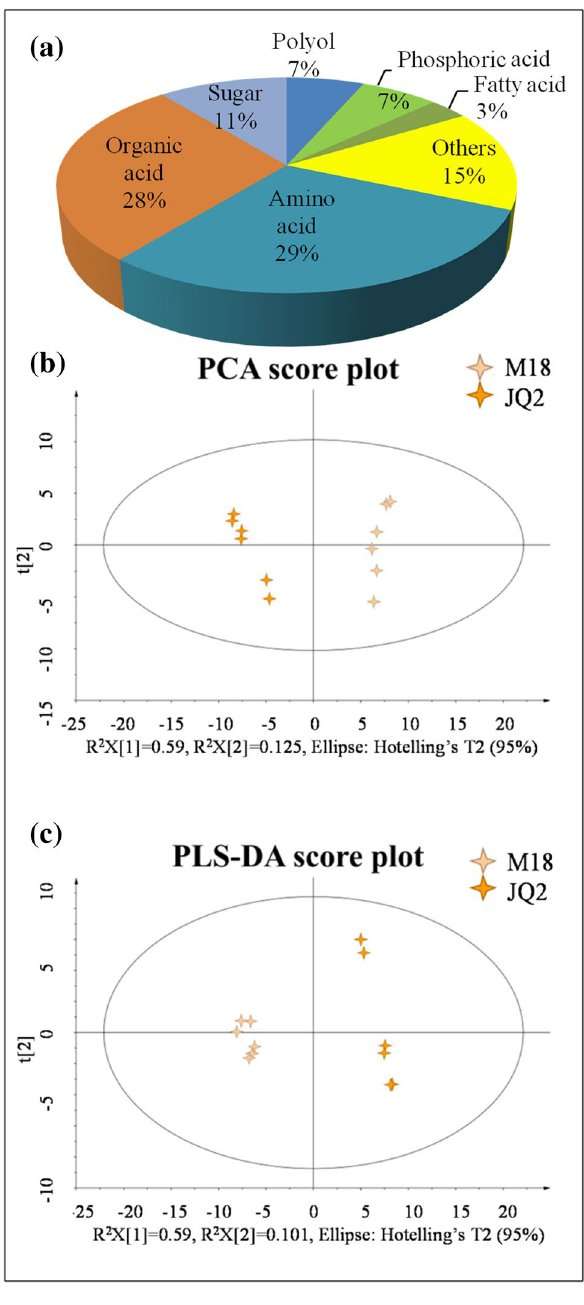
Figure 3. The groups ( a ), PCA ( b ) and PLS-DA ( c ) of metabolites in Tartary buckwheat grains by GC–MS. Multivariate statistical analysis was performed using the software package SIMCA-P (V13.0) and R language ropls